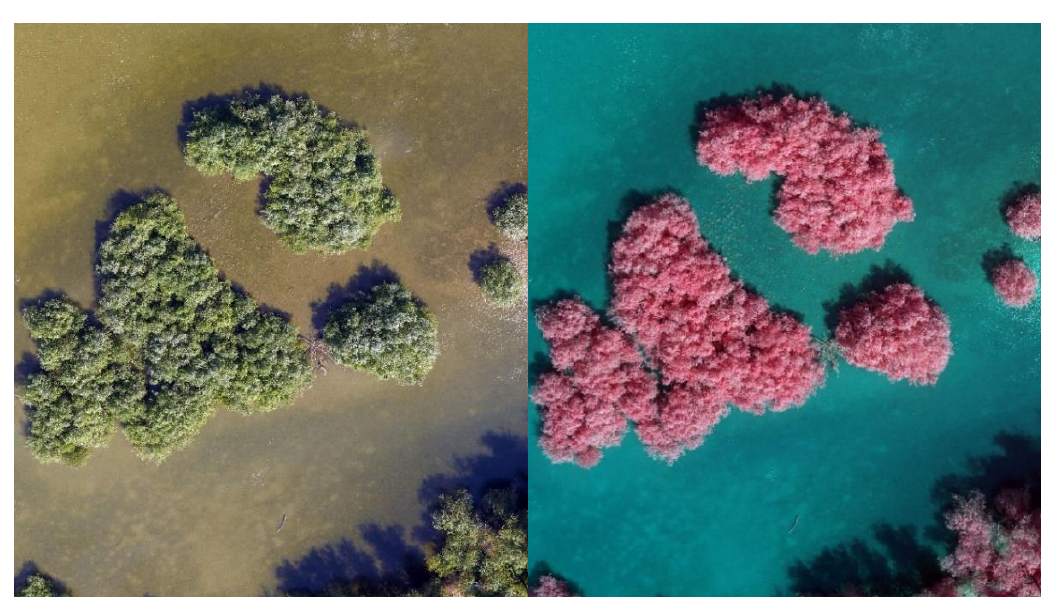
Figure 2. True Color Image of flooded area (left) and false-color composite (right) revealing